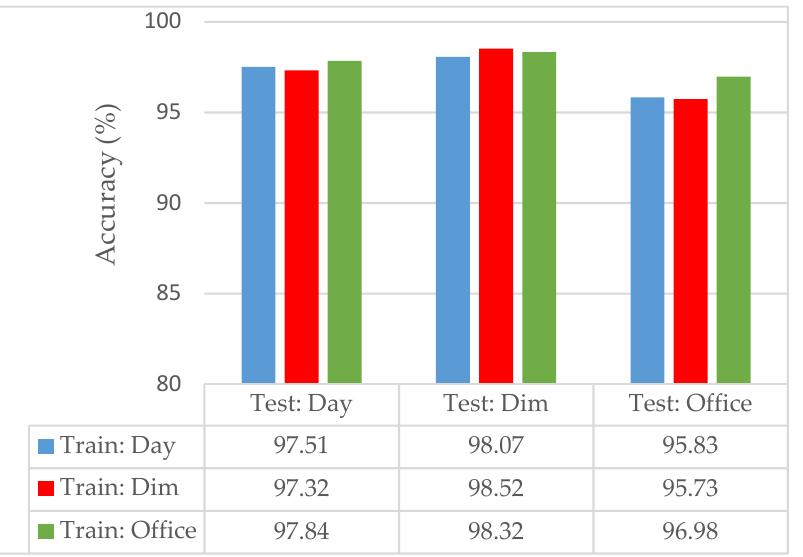
Figure 13. The performance of LDA-CNN model on cross-light experiments using VISOB dataset.